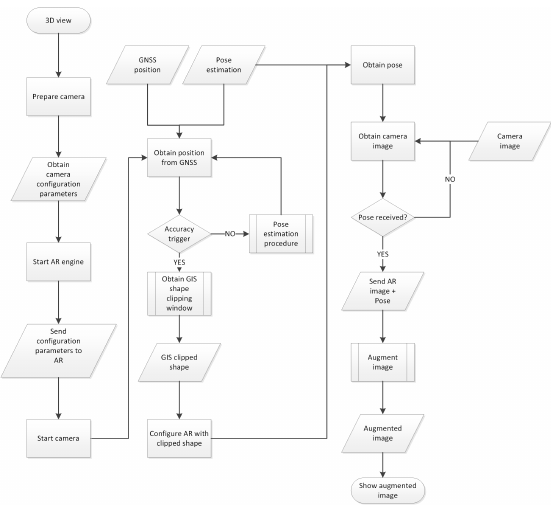
Figure 6: Systems synchronisation